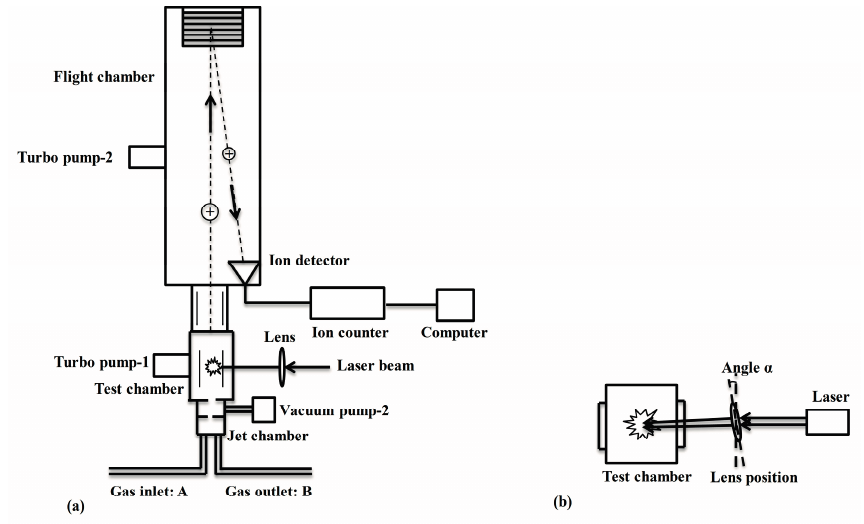
Figure 4. Schematic diagram of the laser breakdown time-of-flight mass